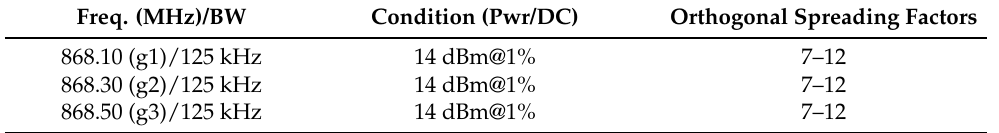
Table 2. LoRaWAN default